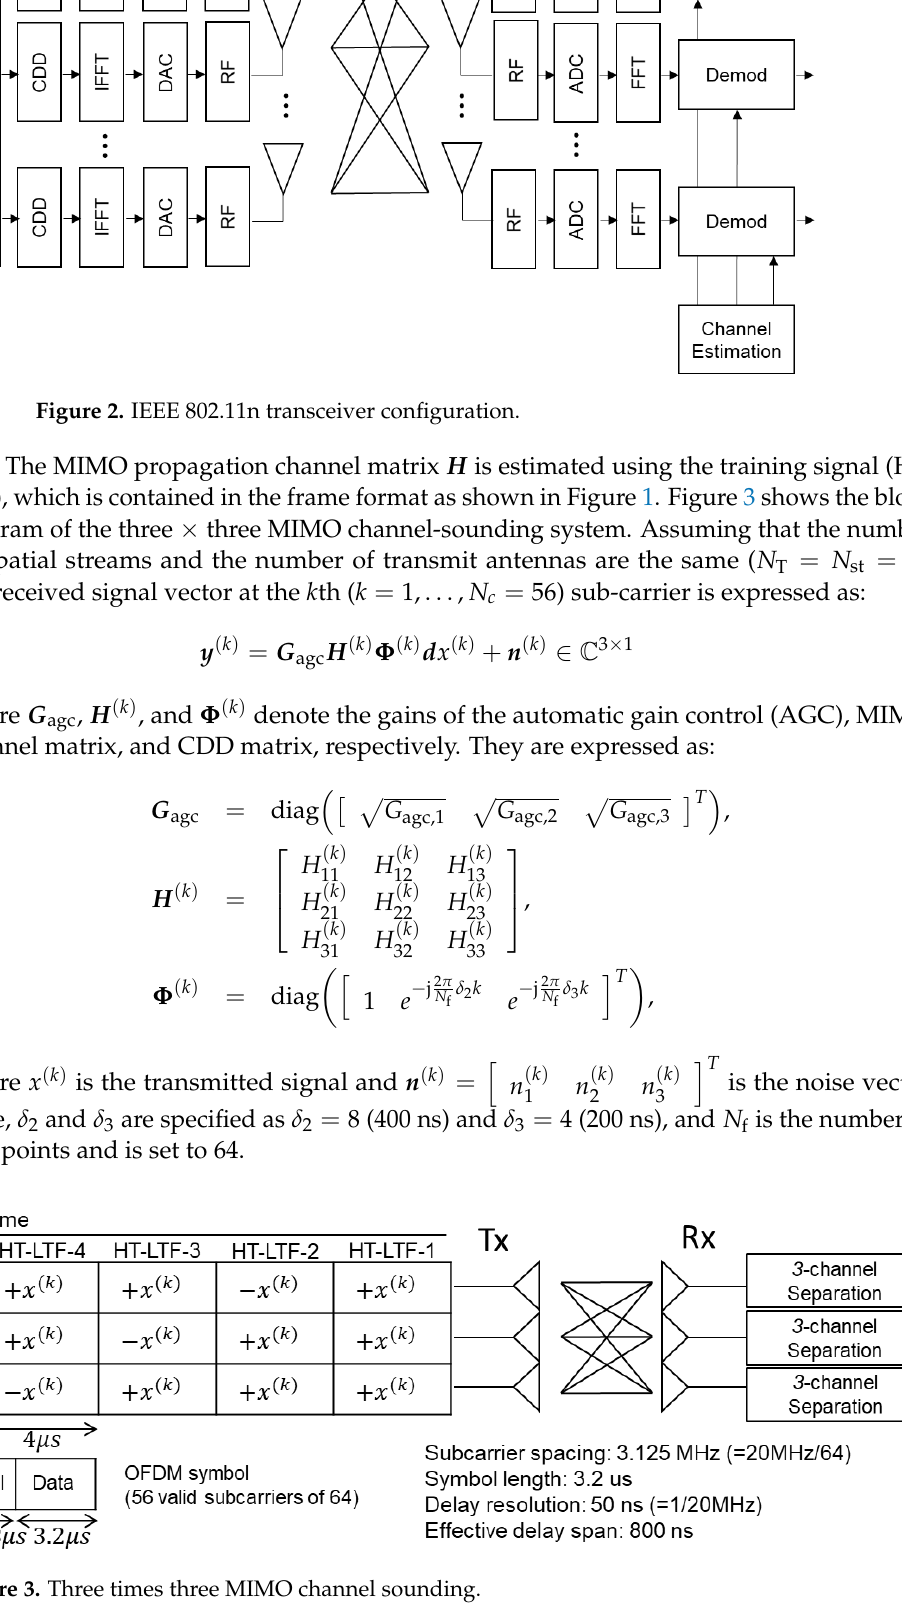
Figure 3. Three times three MIMO channel